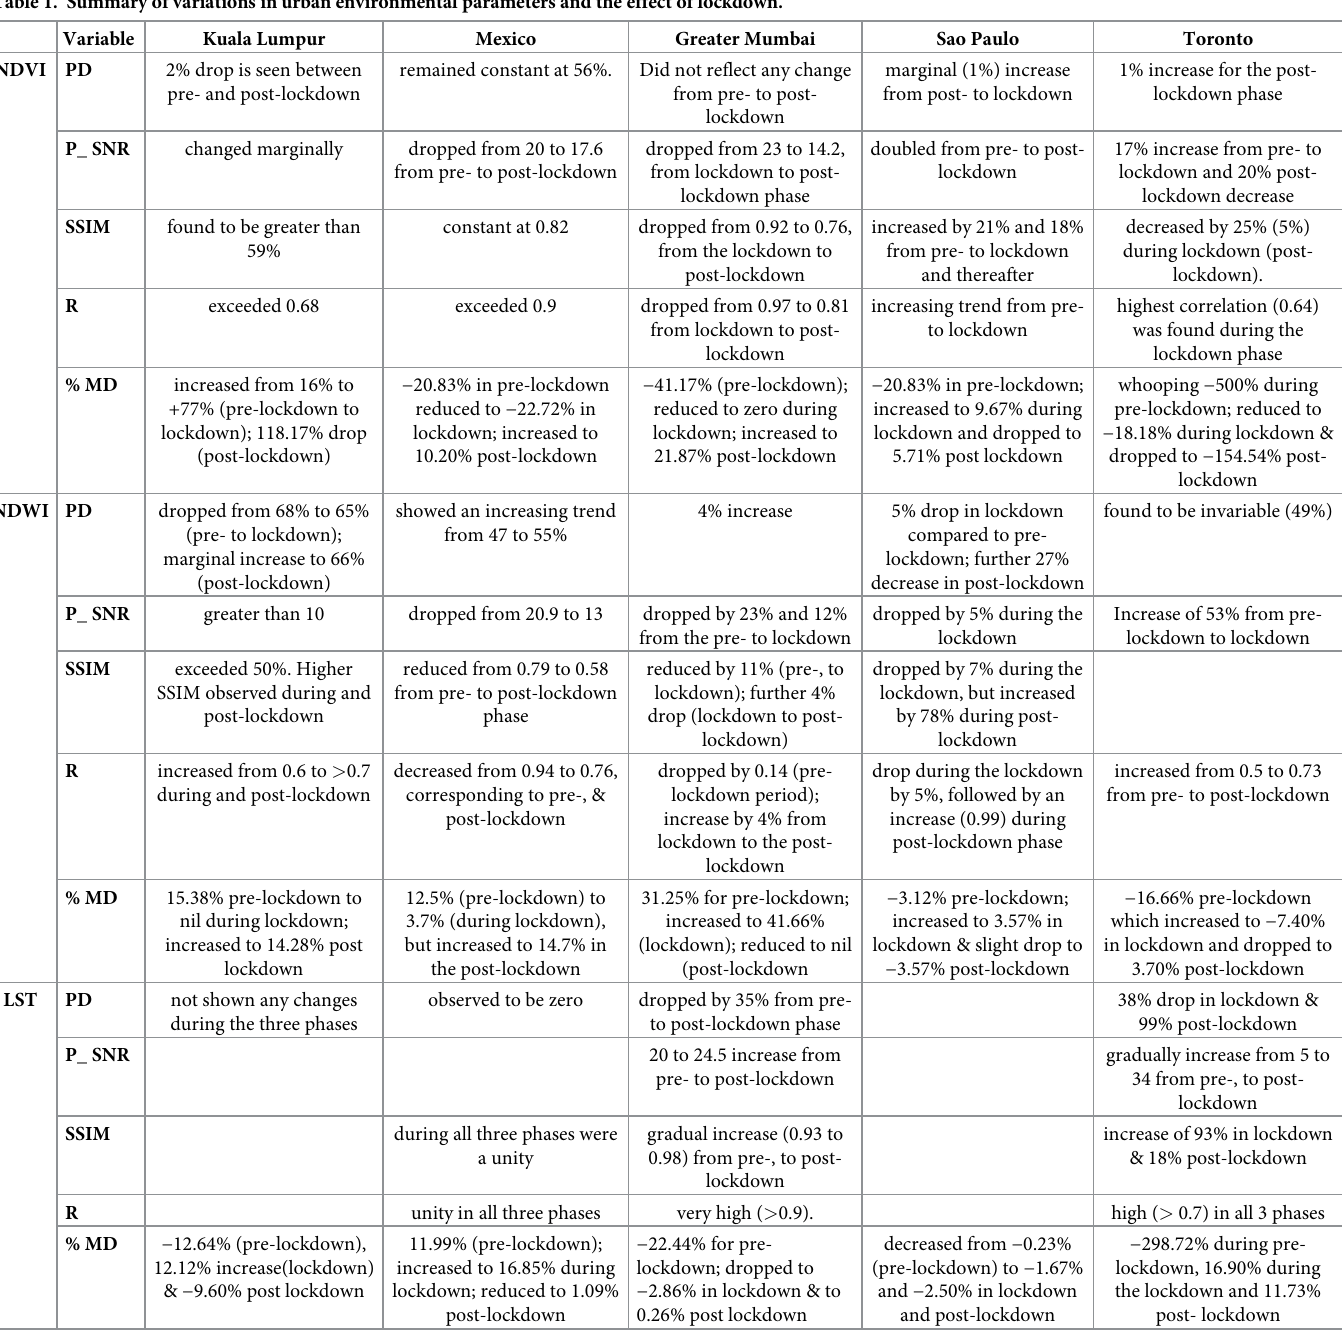
Table 1. Summary of variations in urban environmental parameters and the effect of lockdown.